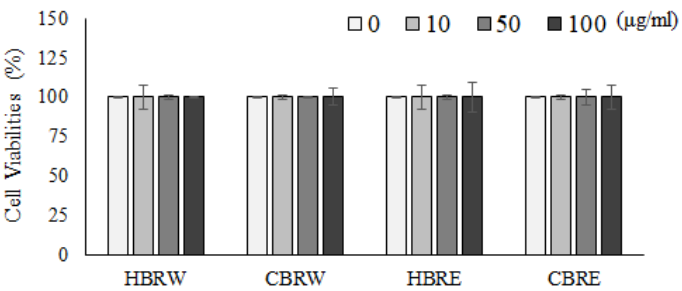
Figure 1. Cell viability of C2C12 myotubes in the presence of 0, 10, 50, and 100 μ g/mL black rice extracts for 24 h. Data are presented means ± SD.